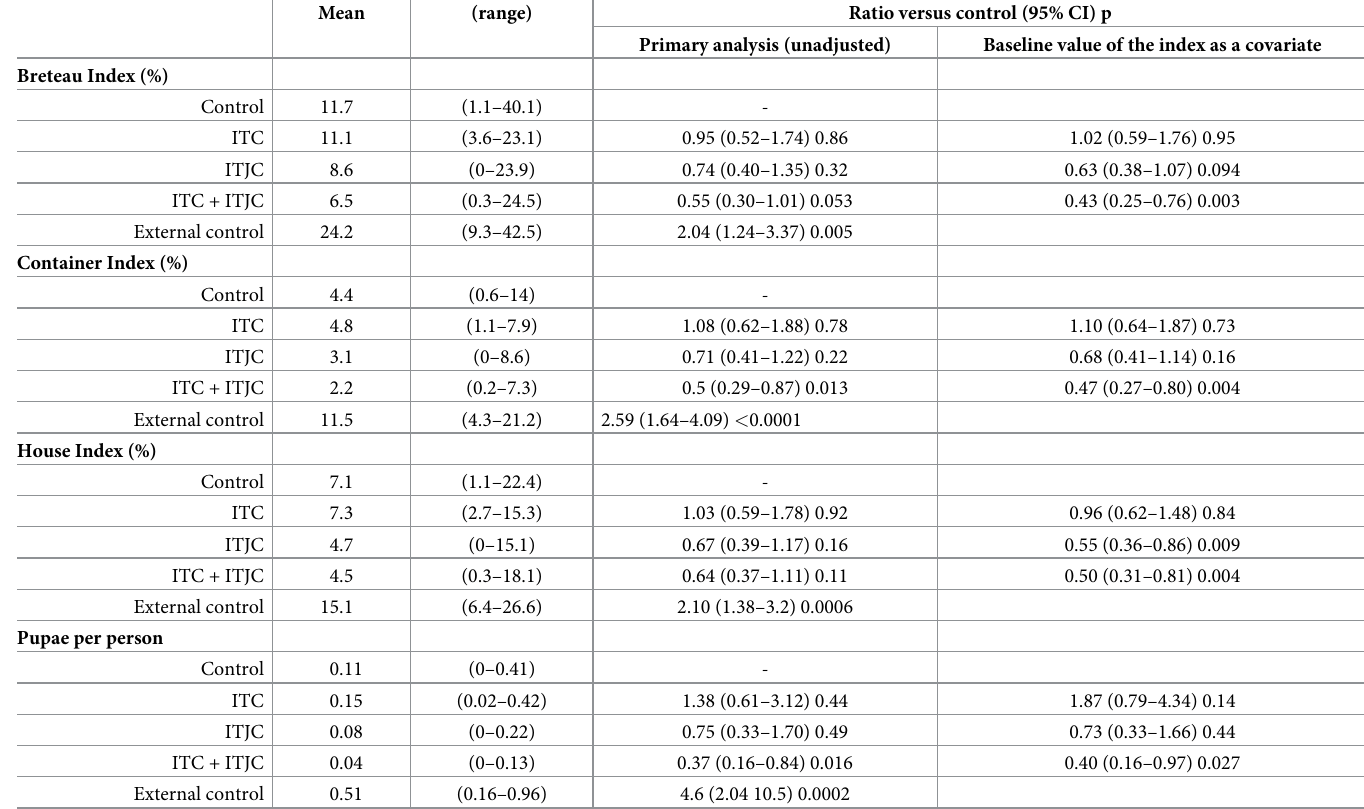
Table 2. Comparison of entomological indices between trial arms. The randomized arms (Control, ITC, ITJC and ITC + ITJC) were compared in a single generalized linear model analysis for each endpoint. The non-randomized external control was compared with the randomized control in a separate analysis for each endpoint.